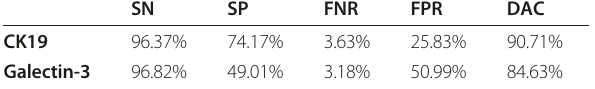
Table 4 Diagnostics performance of CK19 and Galectin-3 in the distinction of PTC from benign thyroid lesions SN SP